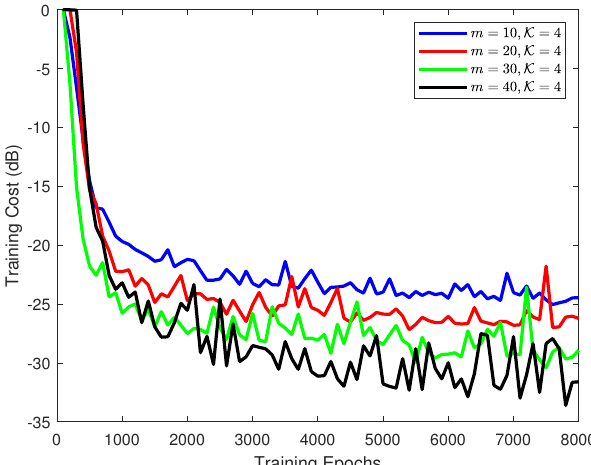
Figure 5. The cost performance comparison under different time steps.